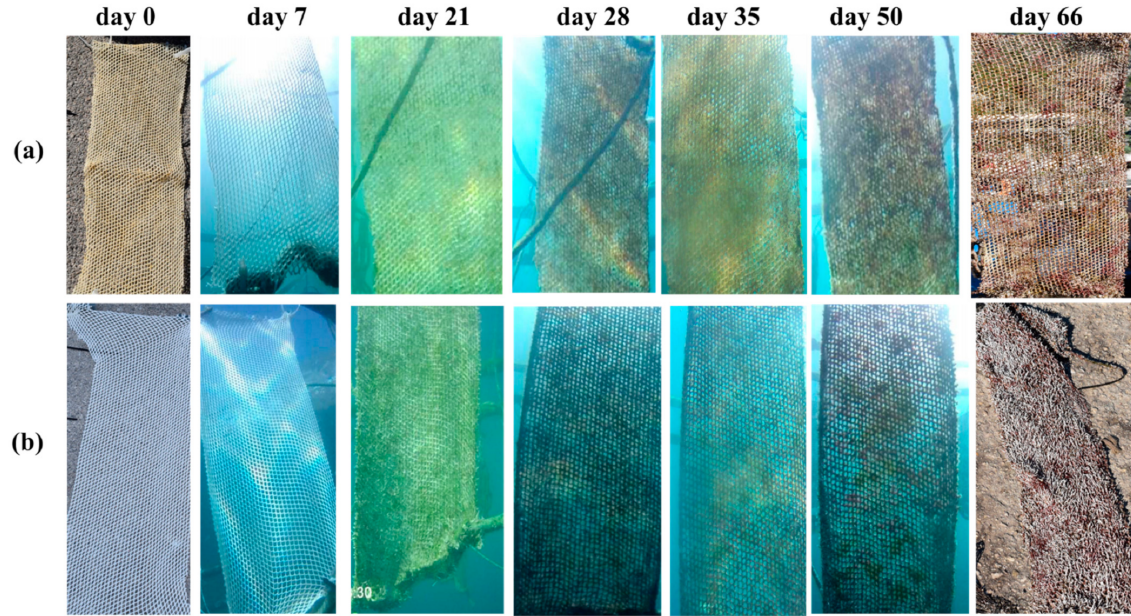
Figure 6. Photographs of the nets coated with P(SSAmC 16 -co-VBCHAM70) ( a ) and uncoated net ( b ) at the beginning of the immersion (t = 0 d) and after 7 d, 21 d, 28 d, 35 d, 50 d, and 66 d of immersion in the sea environment.